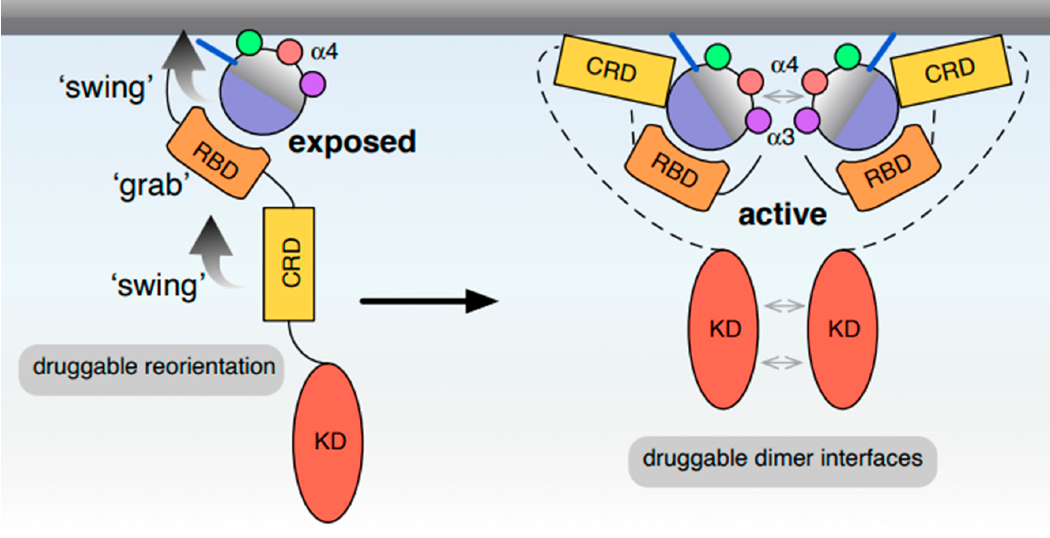
Figure 4. New model for Ras reorientation and RAF-dependent nanoclustering. We propose a ‘grab-and-swing’ model, where reorientation dynamics contribute to the full membrane engagement of Ras-bound binding partners such as the effector RAF (left). The rearrangement of the whole membrane bound complex is then further stabilized by at least transient dimer interfaces of Ras. Note that high-affinity, rigid Ras dimer formation could impair the activity of the whole complex, while allosteric coupling between the Ras-engaged N-terminus of RAF and its C-terminus reinforces dimerization of the kinase domain, which is required for RAF activation.